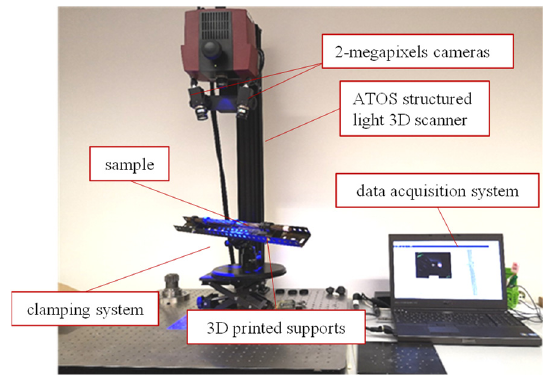
Figure 2. 3D-scanning activity